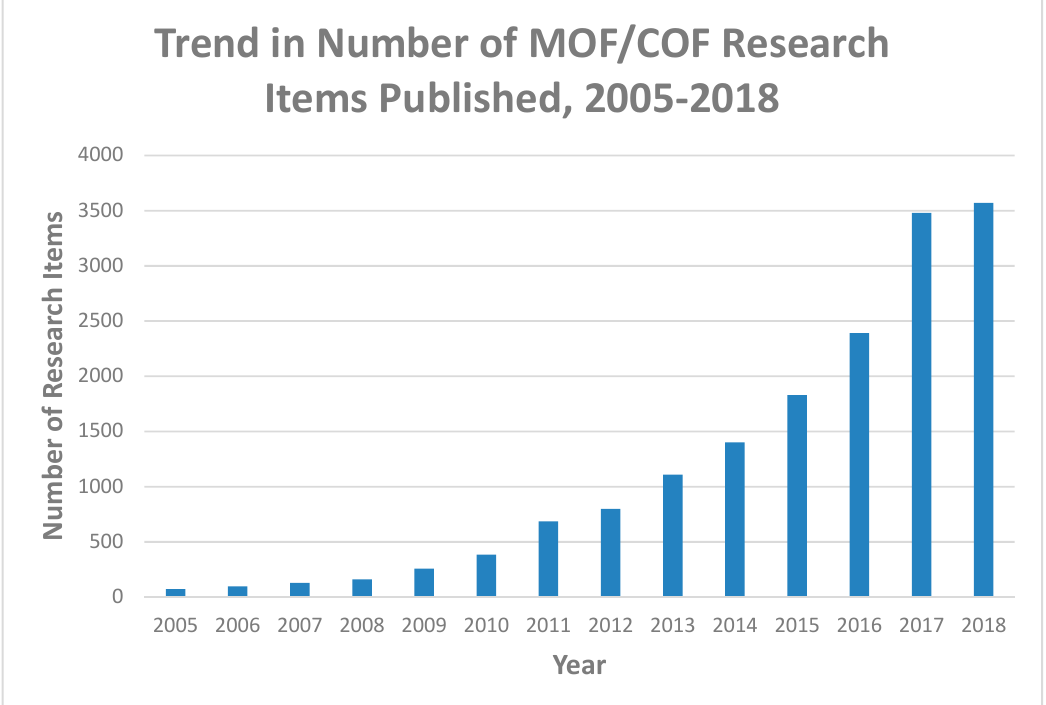
Figure 1. Growth in research interest of covalent organic frameworks (COFs) and metal organic frameworks (MOFs) for biomedical applications. Based on Google Scholar data [33], retrieved 22 August 2018. Google Scholar search term: ‘“metal organic framework” OR “covalent organic framework” biomed OR drug’.